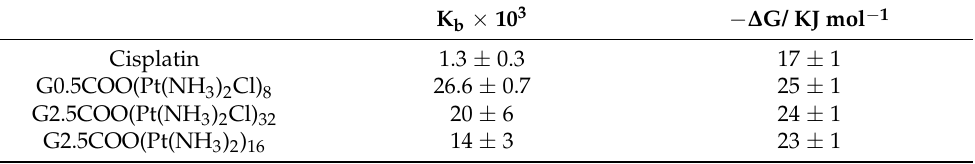
Table 7. Values of DNA binding constant (K b ) and Gibbs free energy ( ∆ G) of the monodentate dendrimers, and free drug cisplatin. Data are represented as mean ± SD of two independent